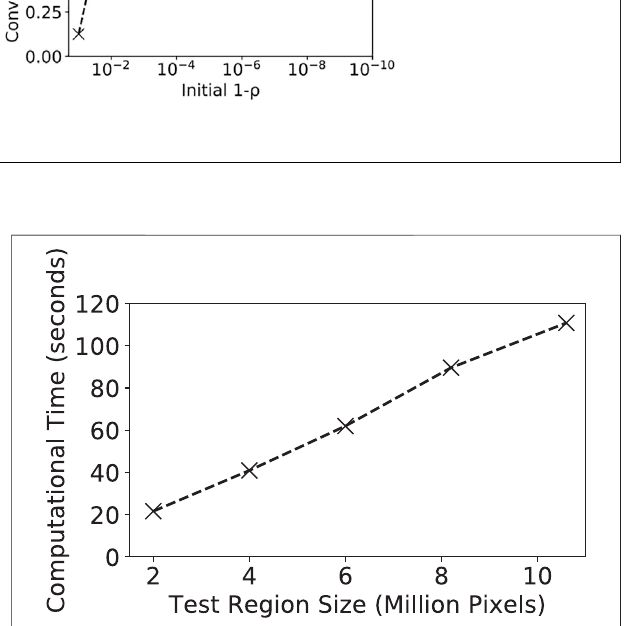
FIGURE 5 | Parameter iterations and convergence in our model.